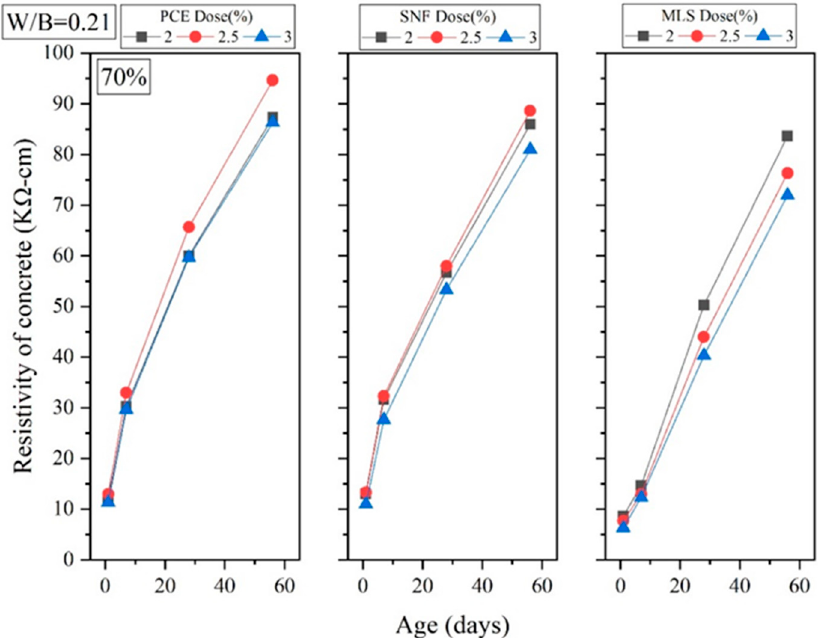
Figure 22. Four-terminal resistance of green and ecofriendly grouting material with sand content of 60%.